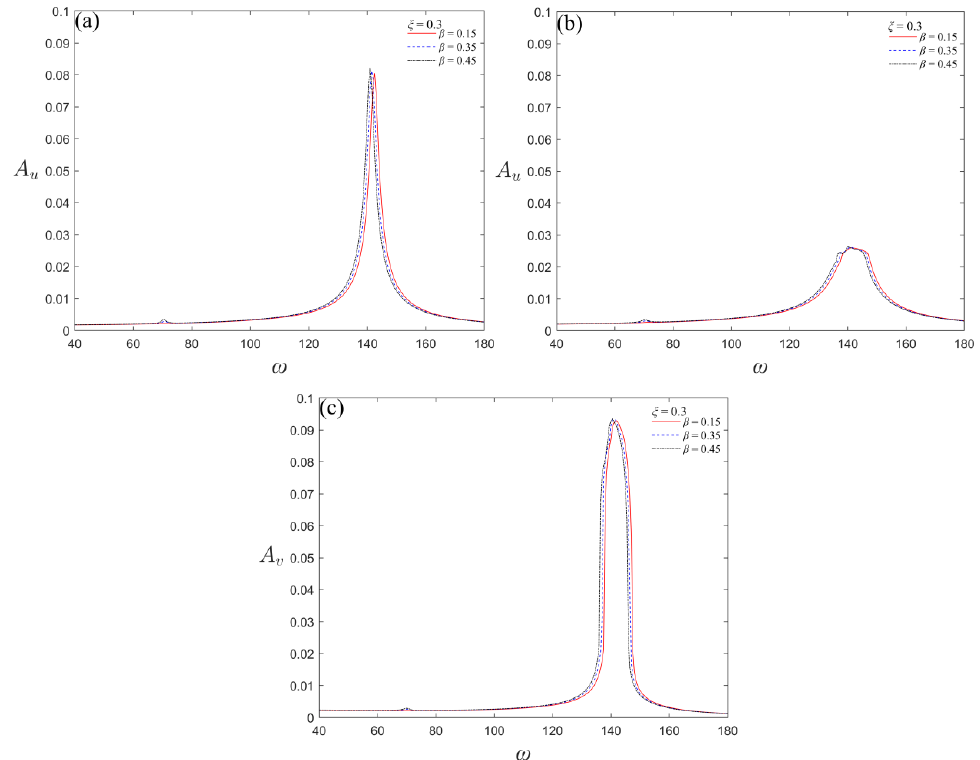
Figure 11. Frequency responses of beam and NES with different crack parameters; ( a ) beam without NES, ( b ) beam with NES, ( c ) NES.